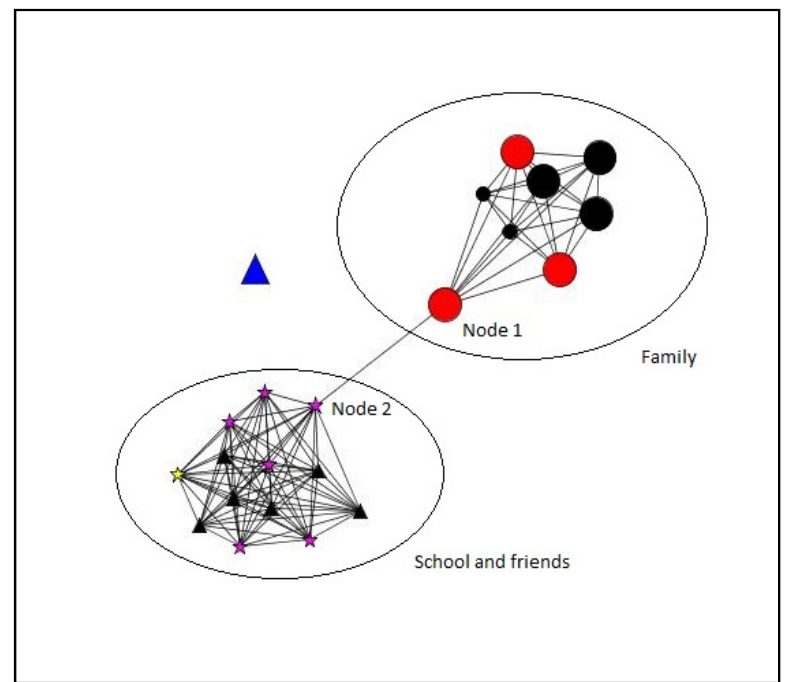
Figure 3. Case 1. Boy. 21 years old. Post-school group.